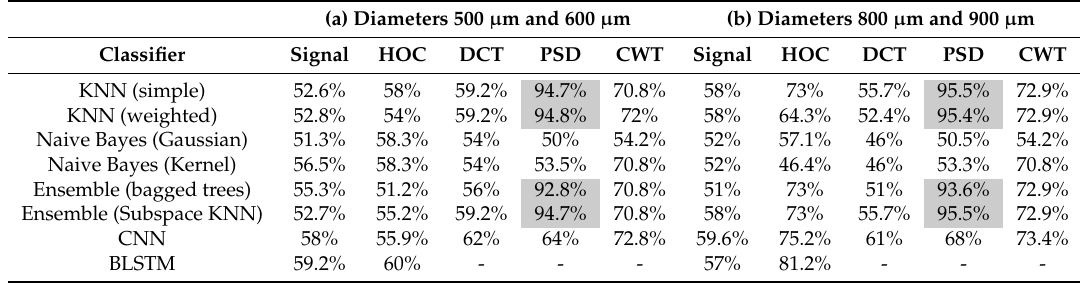
Table 3. Classification accuracy for damaged samples. Accuracy of better than 90% is shown in grey